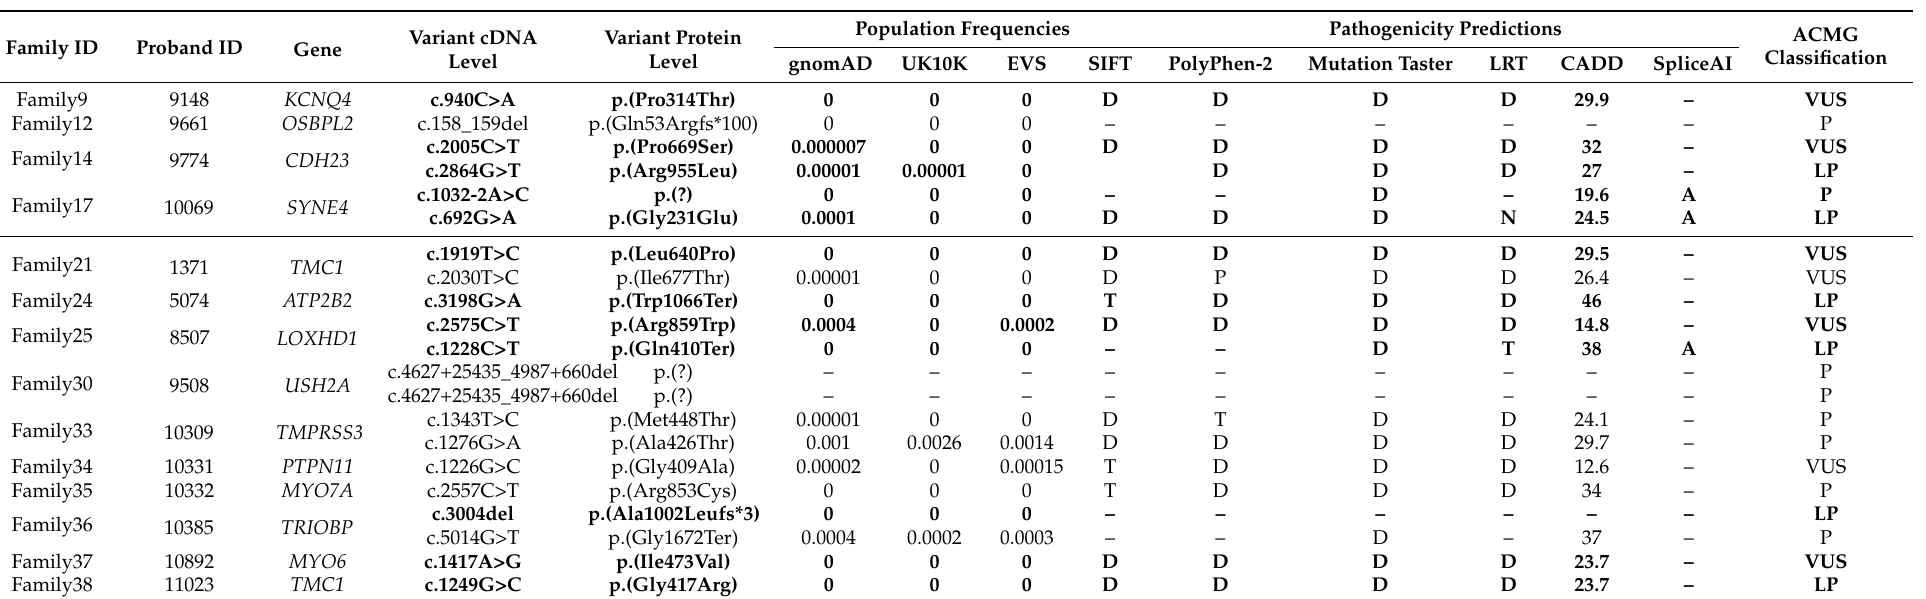
Table 2. List of the identified probably causative